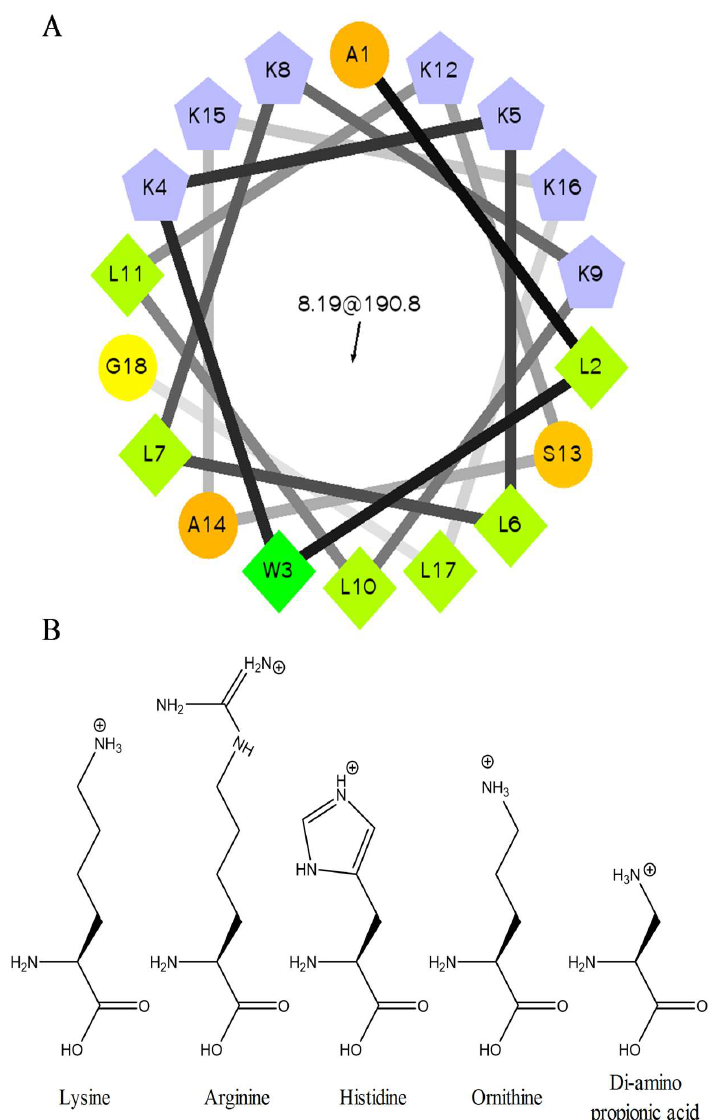
Figure 1. Peptide and amino acid structures. ( A ) The C18G sequence is depicted in a helical wheel diagram where cationic amino acids are blue, hydrophobes are green, and polar-uncharged are orange. ( B ) The chemical structures of the cationic amino acids used in this study are shown at the bottom of the figure. The helical wheel diagram was created using software created by Don Armstrong and Raphael Zidovetzki. Version: Id: wheel.pl,v 1.4 2009-10-20 21:23:36 don Exp.